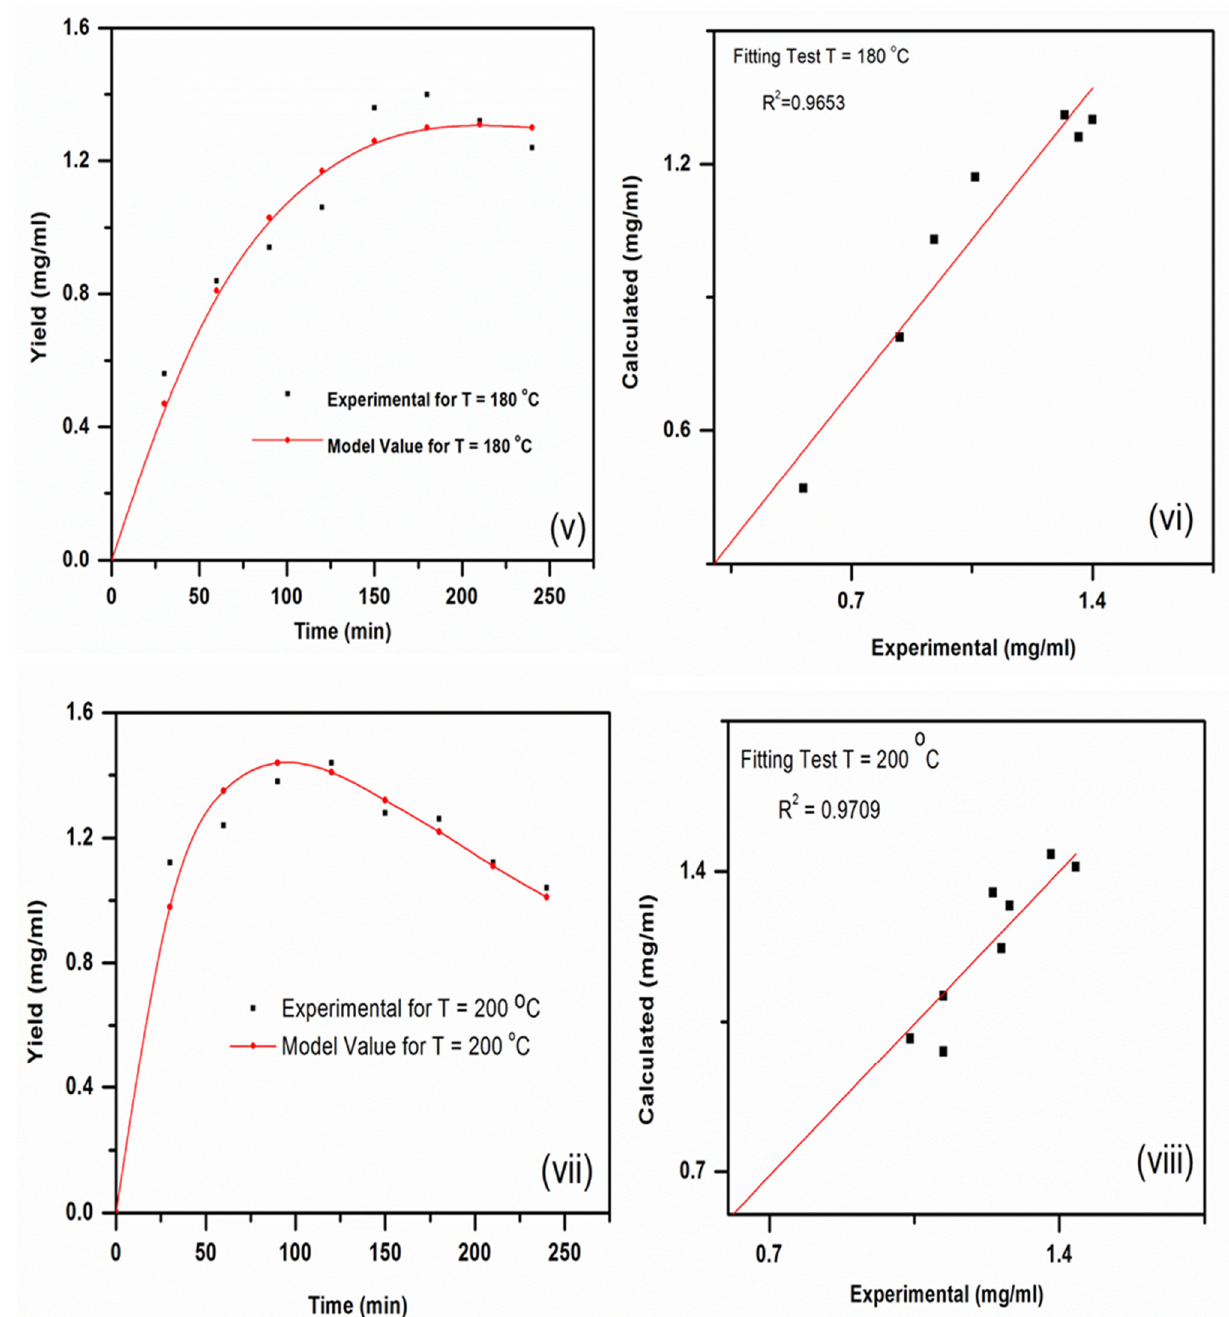
Figure 7. Kinetic modeling of cellulose hydrolysis using H-ZSM-5 catalyst in [BMIM] Cl-water media. ( i ) Experimental and model data at 140 ◦ C, ( ii ) Fitting test at 140 ◦ C, ( iii ) Experimental and model data at 160 ◦ C, ( iv ) Fitting test at 140 ◦ C, ( v ) Experimental and model data at 180 ◦ C, ( vi ) Fitting test at 180 ◦ C, ( vii ) Experimental and model data at 200 ◦ C, ( viii ) Fitting test at 200 ◦ C